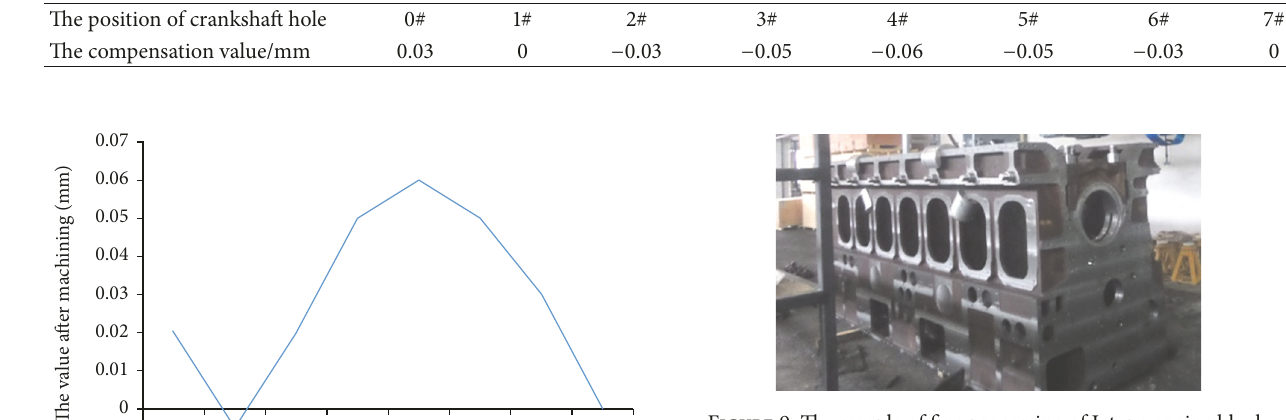
Figure 9: The sample of fine processing of L type engine block.